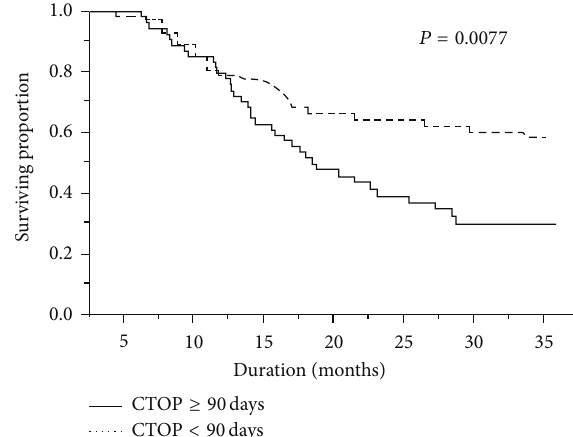
Figure 1: Interval between intra-arterial infusion chemotherapy (IAIC) and surgical resection: effect on overall survival. Kaplan- Meier plots of overall survival in patients with locally advanced oral squamous cell carcinoma: IAIC-surgery intervals ≥ 90 days versus IAIC-surgery intervals < 90 days. CTOP: duration of induction chemotherapy before surgical